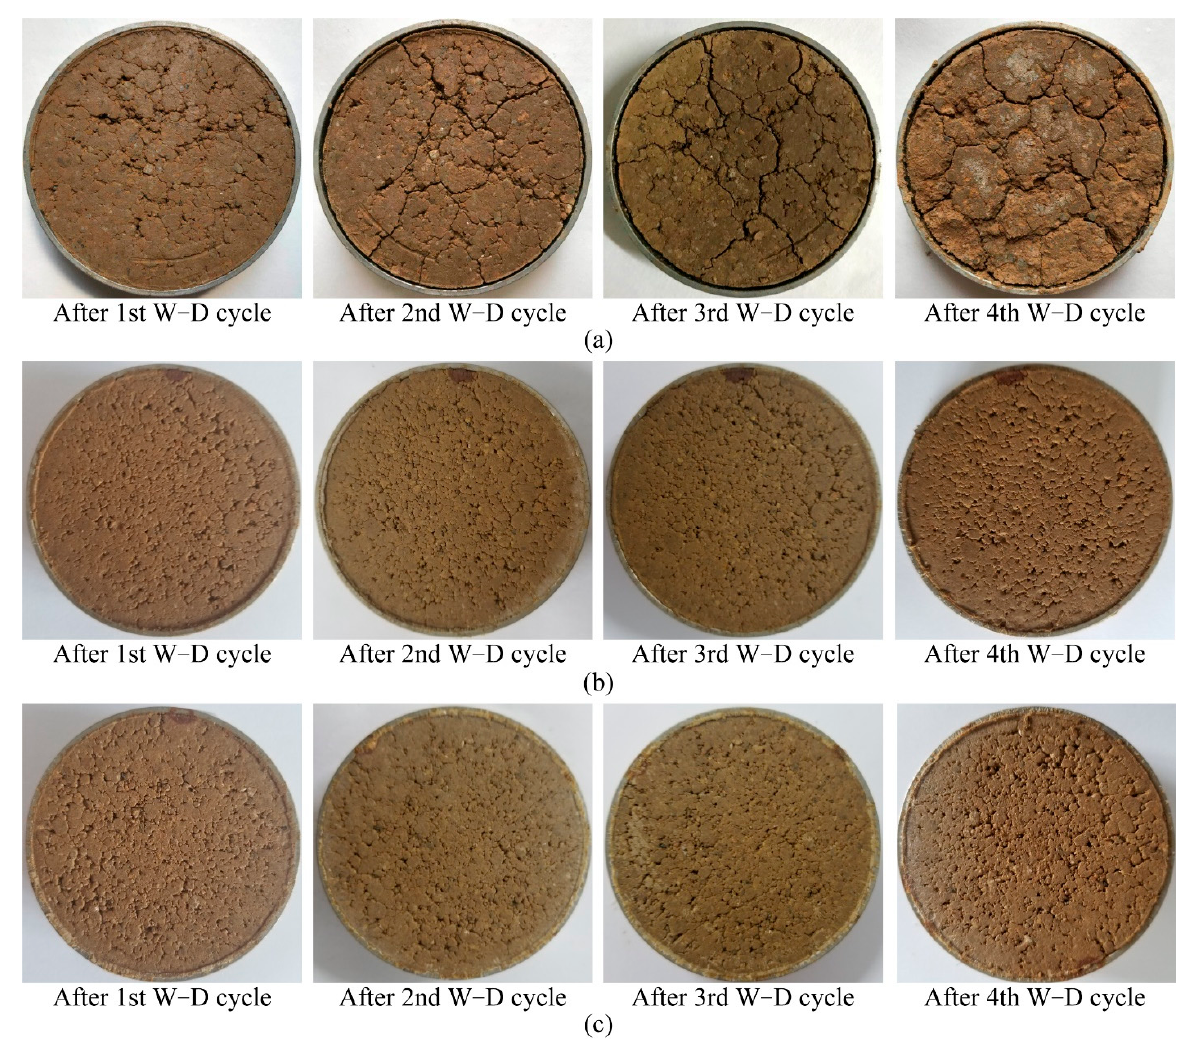
Figure 13. Photographs of surfaces of samples after wetting–drying (W–D) cycles for: ( a ) natural sample; ( b ) treated sample with 27.5% CaCl 2 and 26.5% Na 2 CO 3 ; and ( c ) treated sample with 27.5% CaCl 2 and 21.2% Na 2 CO 3 .